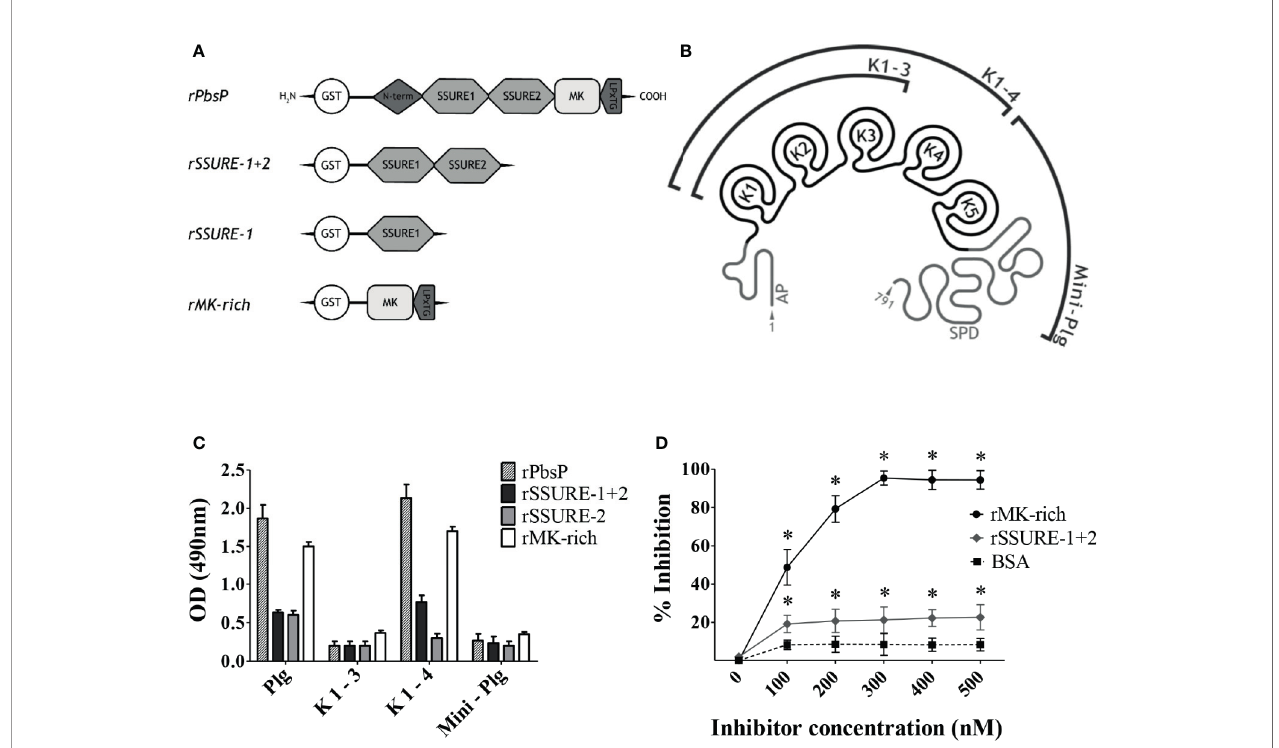
FIGURE 1 | The Kringle 4 domain of Plg is required for binding to PbsP. (A) , Schematic representation of recombinant Plasminogen binding surface Protein (PbsP) and its derived recombinant fragments. (B) , Structure of human Glu-Plasminogen and its fragments: AP domain, K 1-3 encompassing Kringle 1 to 3, K 1-4 encompassing Kringle 1 to 4 and Mini-Plg encompassing Kringle 5 and S1 Peptidase Domain (SPD). (C) , ELISA for selective binding of PbsP and its fragments to Plg and its derivatives. An equimolar amount of rPbsP and its derived fragments (250 nM) was immobilized on the surface of microtiter wells, and their binding was tested with Plg, K1-3, K1-4, or Mini-Plg (100 nM). Complexes were detected with polyclonal anti-Plg antibodies followed by HRP-conjugated goat anti-rabbit IgG. (D) , Selective inhibition of PbsP-Plg interactions. Competitive ELISA assays were done with immobilized rPbsP (250 nM) to which Plg (100 nM) was added in the presence of increasing concentrations of rSSURE-1+2 or rMK-rich fragments. BSA (bovine serum albumin) was used as a control inhibitor. Inhibition ability is shown as percentage. Data are means ± SD from three independent experiments conducted in duplicate. *p <0.05 as determined by Wilcoxon rank sum test